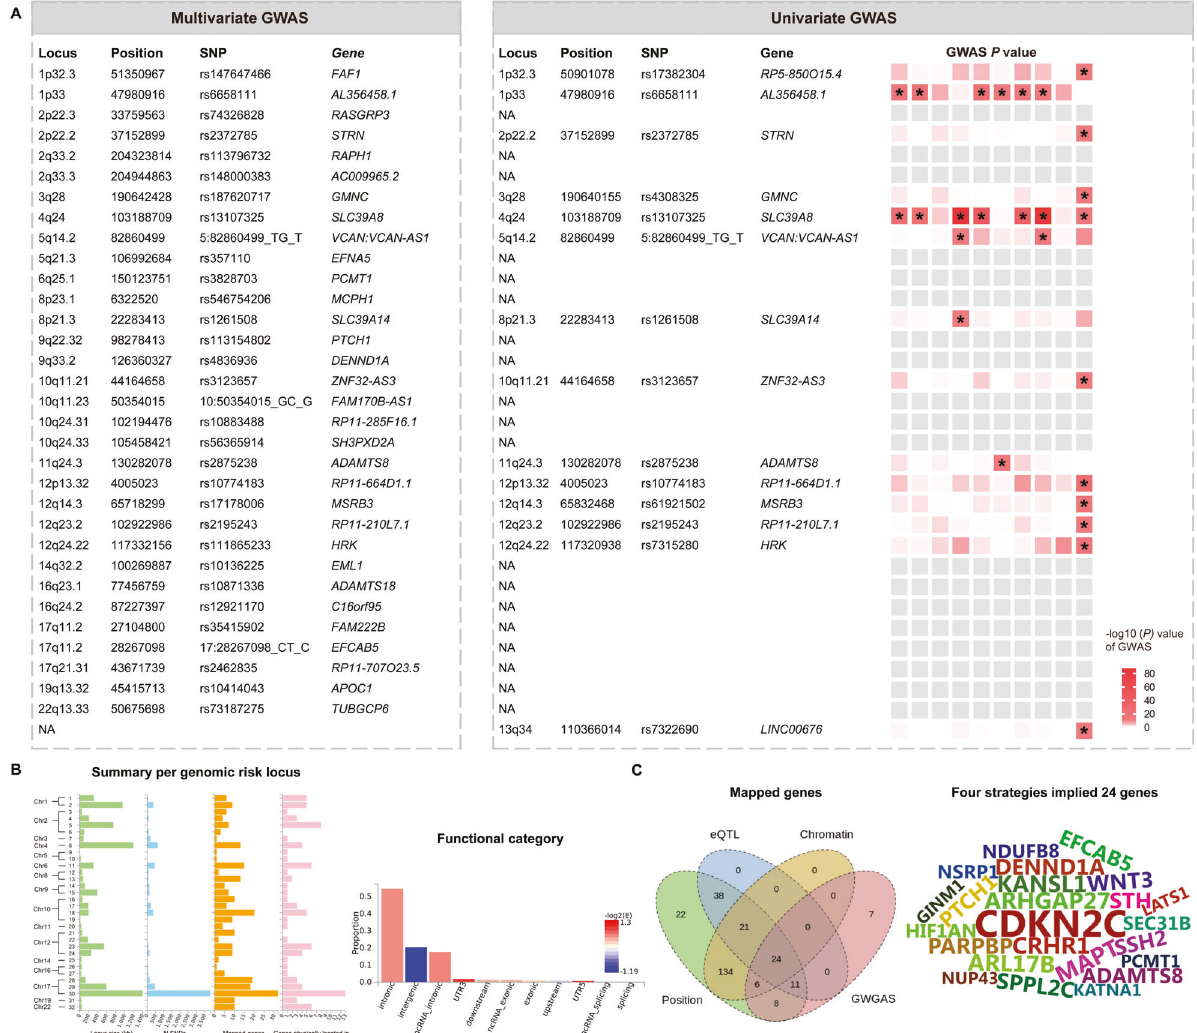
Fig. 3 The comparison of genetic loci between the multivariate and univariate GWAS, and functional annotation. A The left column indicates the 32 genetic loci identi fi ed by the multivariate GWAS, whereas the right column indicates the 14 loci identi fi ed by the univariate GWAS. The heatmap shows, from left to right, accessory basal nucleus, anterior amygdaloid area-AAA, basal nucleus, central nucleus, cortical nucleus, corticoamygdaloid transition, lateral nucleus, medial nucleus, paralaminar nucleus and whole amygdala volumes. Signi fi cant loci in the univariate GWAS ( P < 5 × 10 − 09 ) are marked with an asterisk *. 13 of the 14 loci identi fi ed in the univariate GWAS were replicated in the multivariate GWAS, except the 13q34 locus speci fi c for the whole amygdala volume. B Functional annotation of the genomic loci and identi fi ed SNPs. Left panel, overview of the genomic loci sizes and number of variants. Right panel, distribution of functional consequences of SNPs in signi fi cant genomic loci. C Gene mapping consequences of the signi fi cant SNPs. Left panel, venn diagram showing the number of genes mapped by the four different strategies, i.e., positional (green), eQTL (blue), chromatin interaction mapping (yellow), and identi fi cation by the GWGAS (red). A total of 271 genes were identi fi ed by four approaches. Right panel, 24 genes were identi fi ed by all of the four mapping strategies, showing by the wordcloud plot. GWAS genome-wide association study, SNP single nucleotide polymorphism, eQTL expression quantitative trait themselves as genetically determined regions (Fig. 4A, Supple- ADAM metallopeptidase with thrombospondin type 1 motif 8 mentary Table S11). The LDSC intercepts were close to 1, (ADAMTS8) [48]. suggesting that the observed in fl ation in genetic signal is Gene-set analysis implicated by MAGMA revealed several mostly due to polygenic signal instead of population strati fi cation signi fi cant gene sets involved in cell differentiation/development, [49]. and axon extension functions (Supplementary Table S9). Further We focused on enriched annotations where regression coef fi - functional enrichment analysis using g:Pro fi ler web server cients are signi fi cantly positive (z > 1.96, two-tailed P < 0.05; identi fi ed signi fi cant enrichment within various ion transport- Supplementary Table S12) in strati fi ed LDSC regression. Speci fi - related sets for the majority of the amygdala regions (Supple- cally, we found notable enrichment for three phylogenetically mentary Table S10). conserved cortical regions (i.e., enrichment = 22.63, P = 0.029 for accessory basal; 26.72, 0.018 for corticoamygdaloid transition and SNP-based heritability and partitioned heritability analysis 24.96, 0.033 for paralaminar nucleus) for the annotation “ ancient SNP-based heritability (h 2 ) was 27% for the whole amygdala and sequence age human promoter ” . This conserved promoter ranged from 14% to 25% for the nine nuclei, illustrating